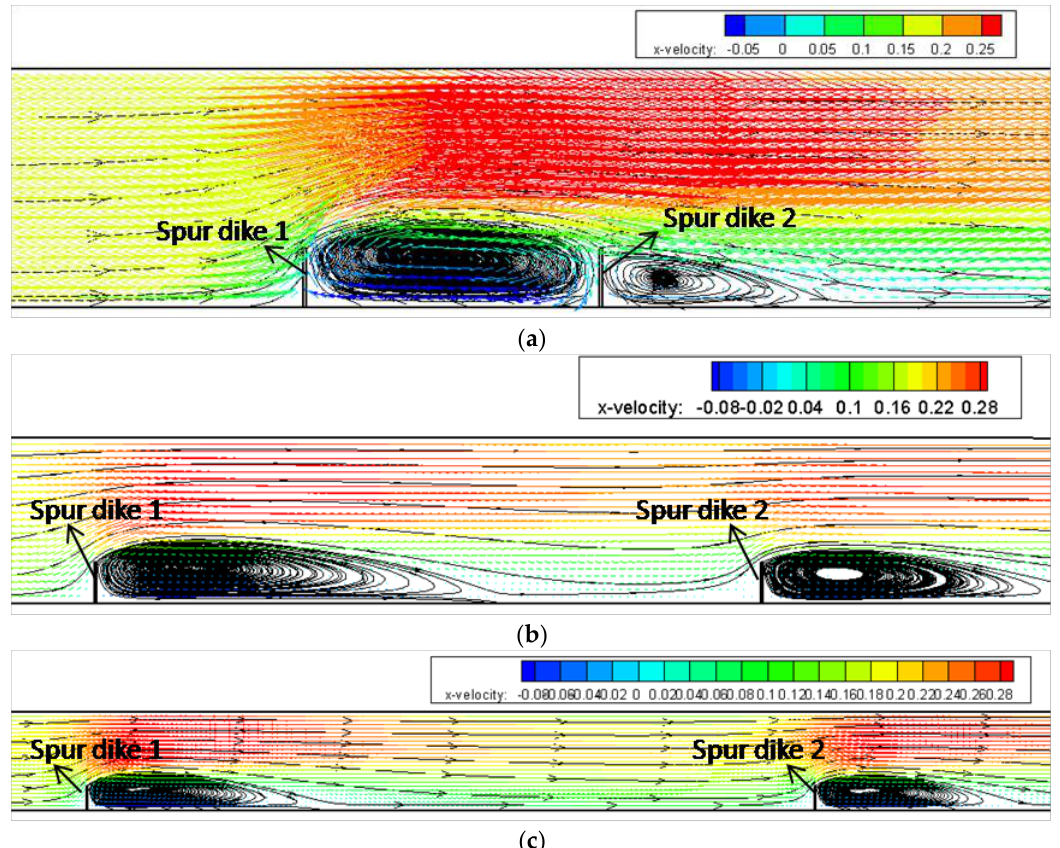
Figure 7. The velocity fields on the horizontal plane of Y = 0.08 m under different dike spacings. ( a ) s = 1.5 m (5 b ). ( b ) s = 4.8 m (16 b ). ( c ) s = 9 m (30 b ). ( a ) s = 1.5 m (5 b ). ( b ) s = 4.8 m (16 b ). ( c ) s = 9 m (30 b ).